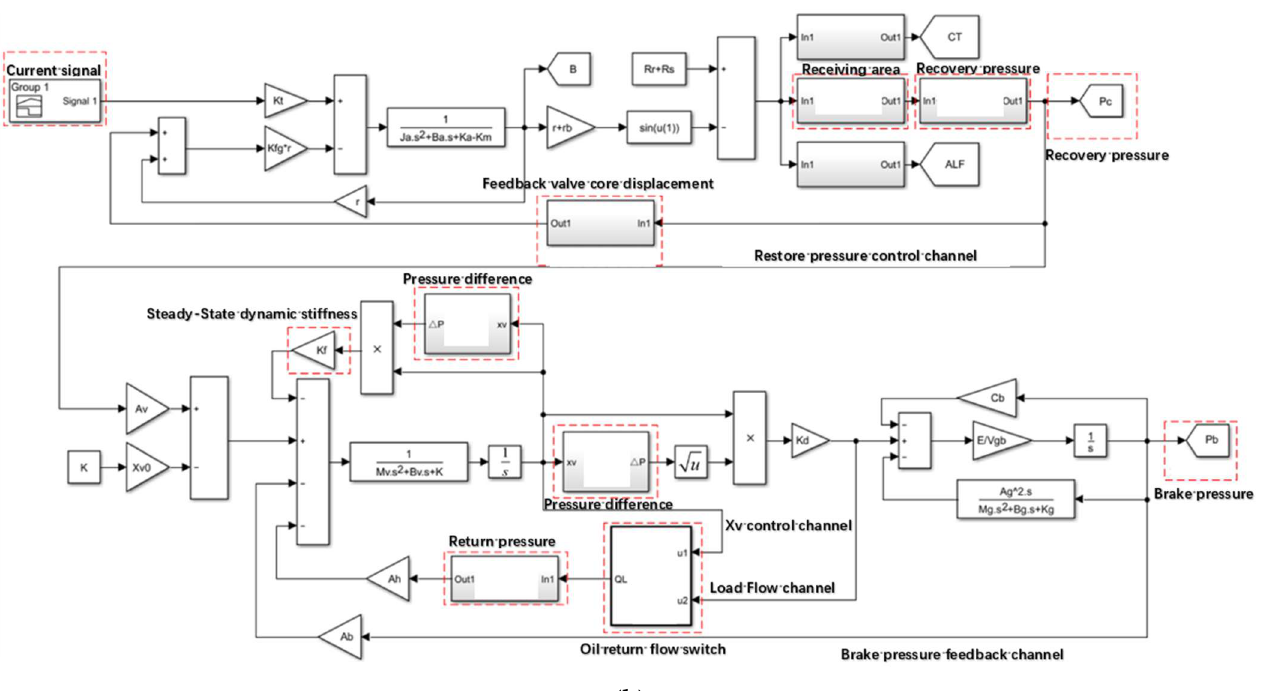
Figure 4. ( a ) Block diagram of ABPSVCS. ( b ) Flow block diagram of ABPSVCS. ( c ) Logical block diagram of hydraulic